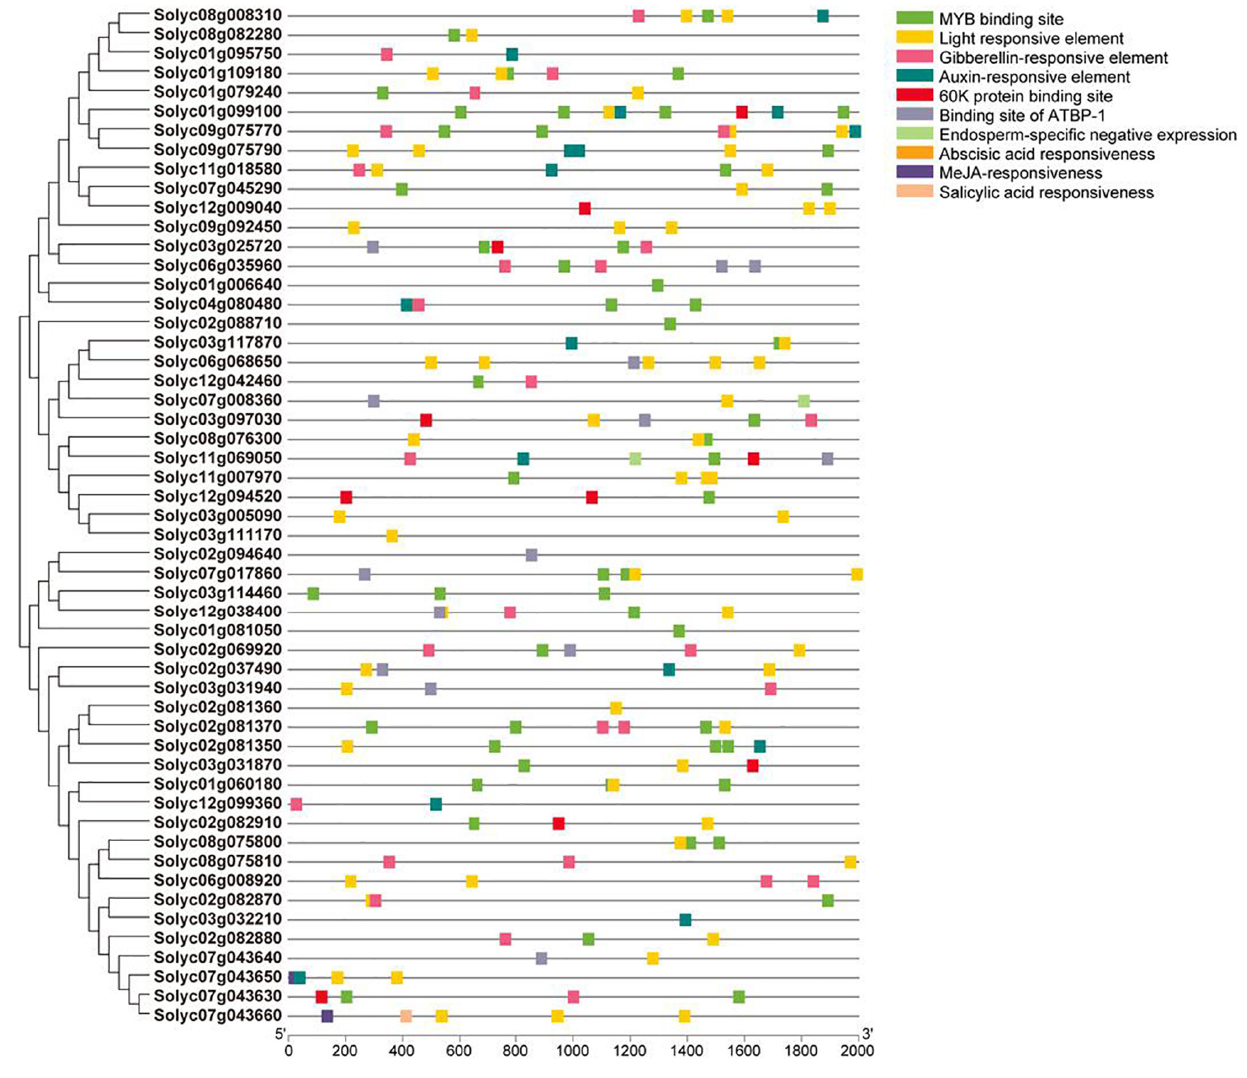
FIGURE 8 | Phylogenetic and cis -element analysis of SlAAE family promoters. A total of 53 of promoter sequences from tomato genome were scanned using PlantCARE. Sorted cis -elements were then mapped on promoters of the corresponding AAEs and visualized using TBtools. Colored rectangles represent different cis